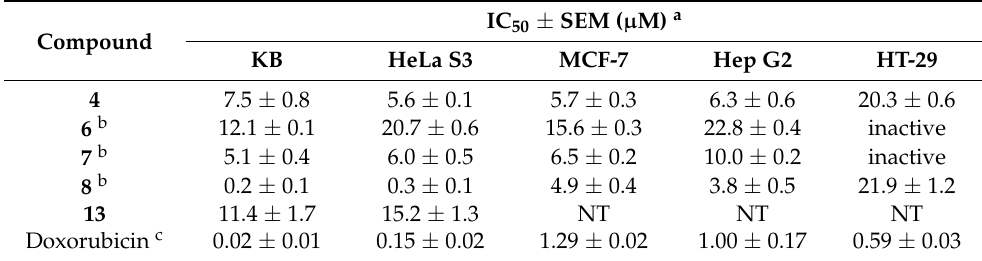
Table 2. Cytotoxic activity of the isolated compounds against five human cancer cell lines. Compound